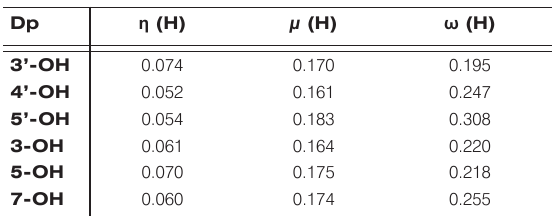
Table 10. Hardness, electronegativity and electrophilic index of malvidin (ROHF/6-31+G(2d,p)). Mv η (H) μ (H) ω (H)